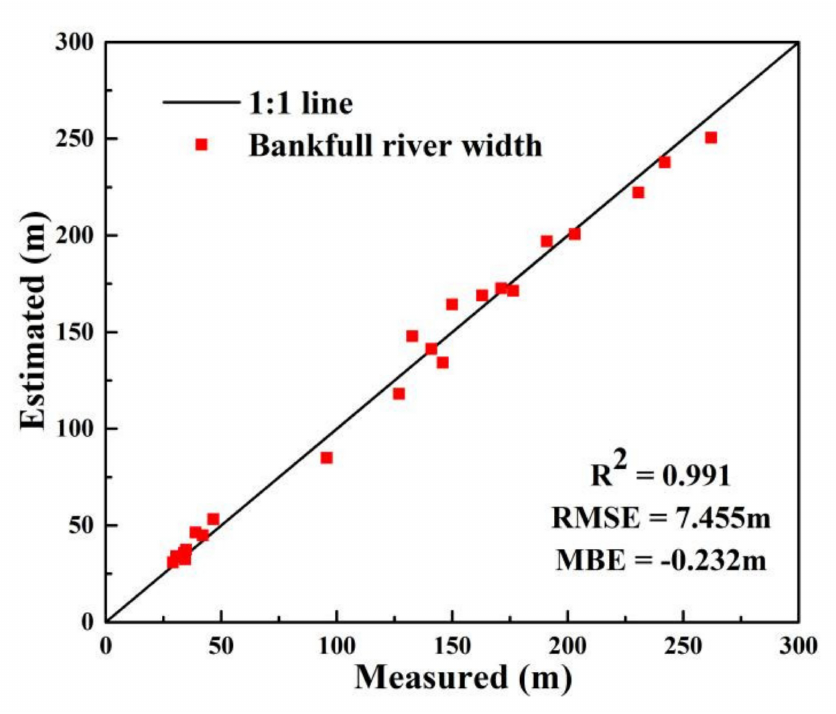
Figure 8. Comparison between the estimated river width and in situ-measured